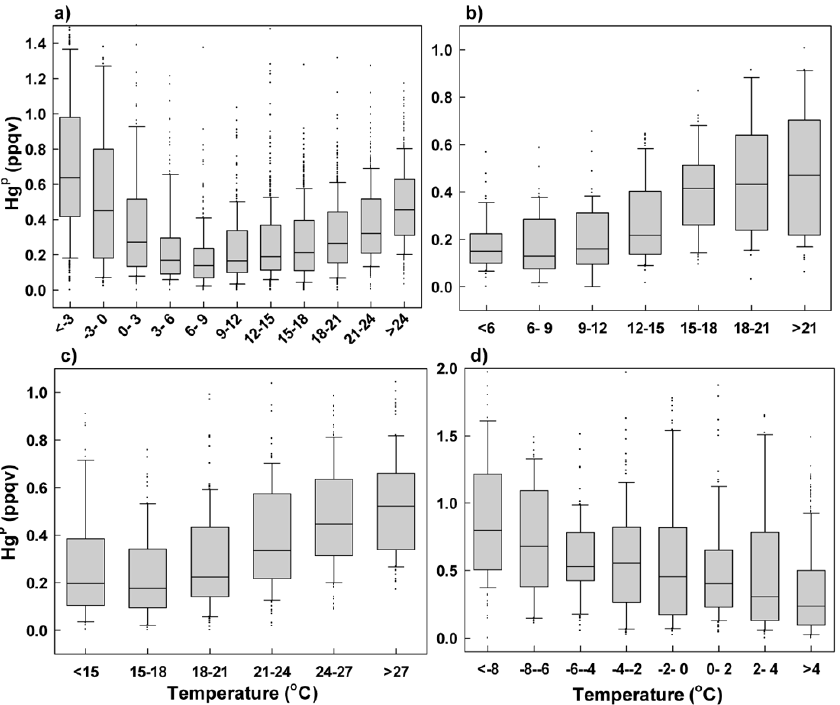
Fig. 10. Relationships between Hg P and temperature at TF (coastal) for (a) all seasons, (b) daytime springs, (c) daytime summers, and (d) winters during January 2009–August